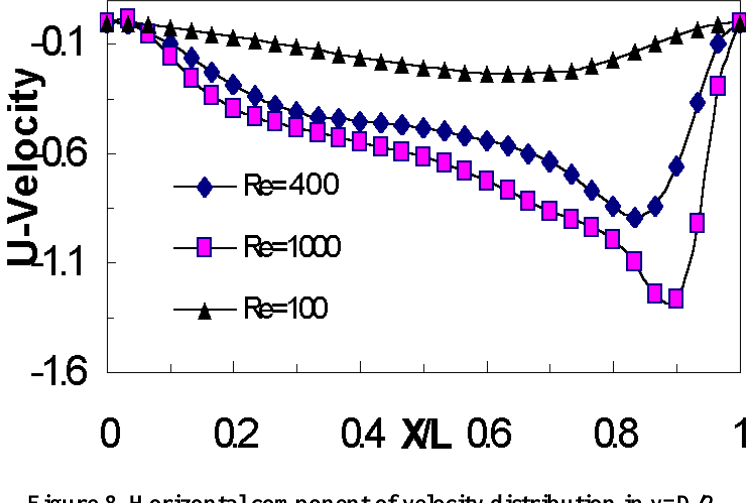
Figure 8. Horizontal component of velocity distribution in